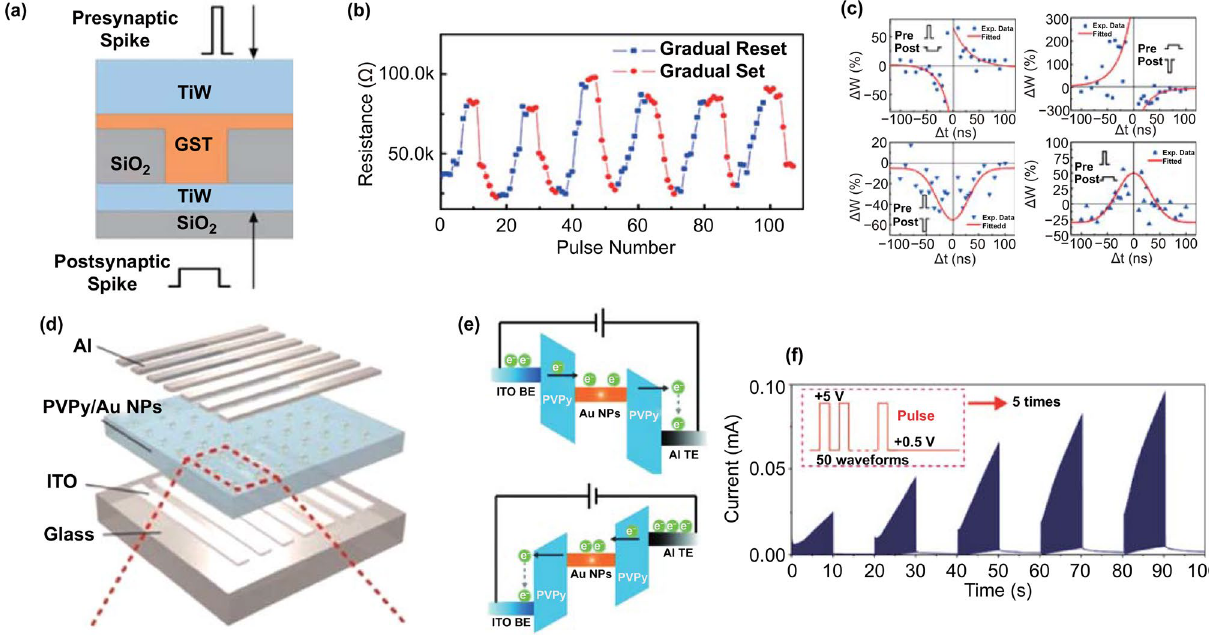
Fig. 4 a Schematic of the electronic synaptic device based on phase-change memory (PCM) materials of Ge 2 Sb 2 Te 5 (GST). b Resistance changes in response to the external electrical pulses for the gradual reset and set. c STDP synaptic functions realized in the device. a – c Repro- duced with permission from Ref. [42]. d Crossbar structure of ITO/poly(4-vinylpyridine) (PVPy)–Au NP/Al RRAM device. e SET (top) and RESET processing (bottom) of the device. f Time-dependent synaptic changes of 50 consecutive pulses. d – f Reproduced with permission from Ref.